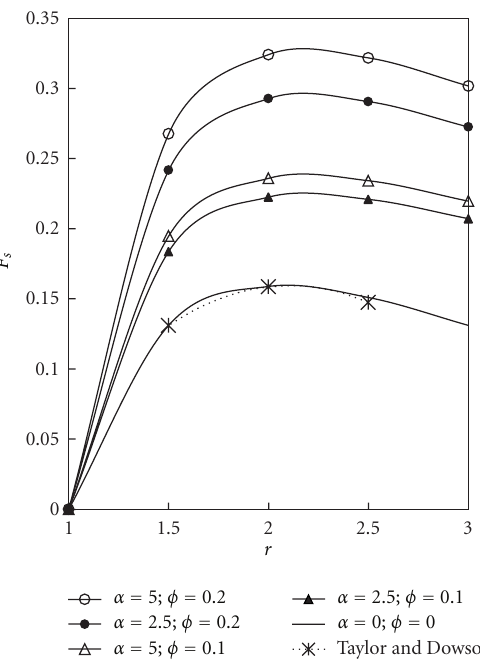
Figure 2: Variation of steady-state load capacity of plane inclined slider with respect to film thickness ratio r for di ff erent values of α and φ .